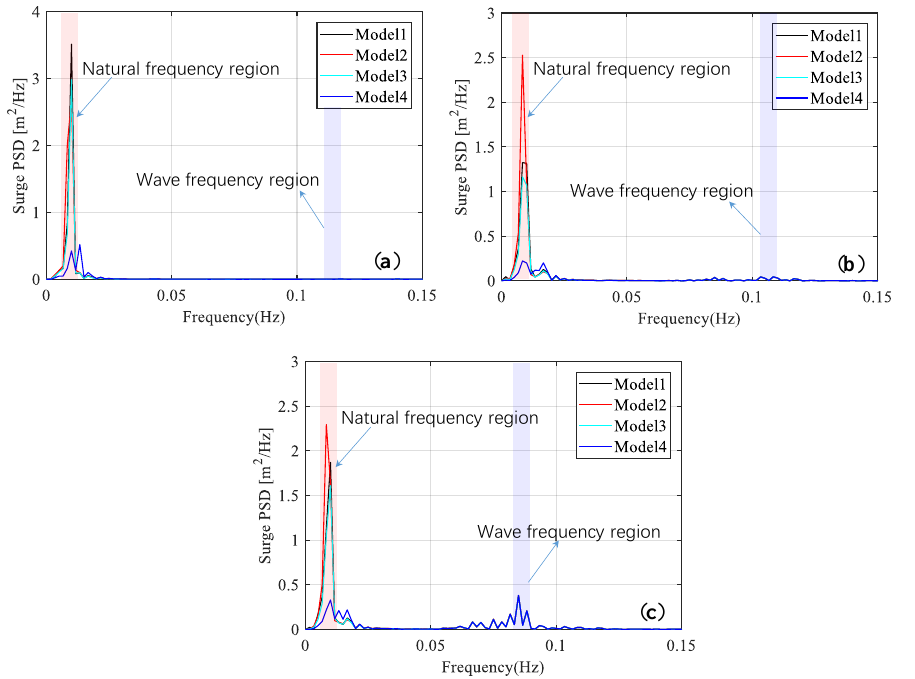
Figure 11. Frequency domain curves of the surge PSD of the multi-segmented mooring line models: ( a ) LC4; ( b ) LC5; and ( c ) LC6.